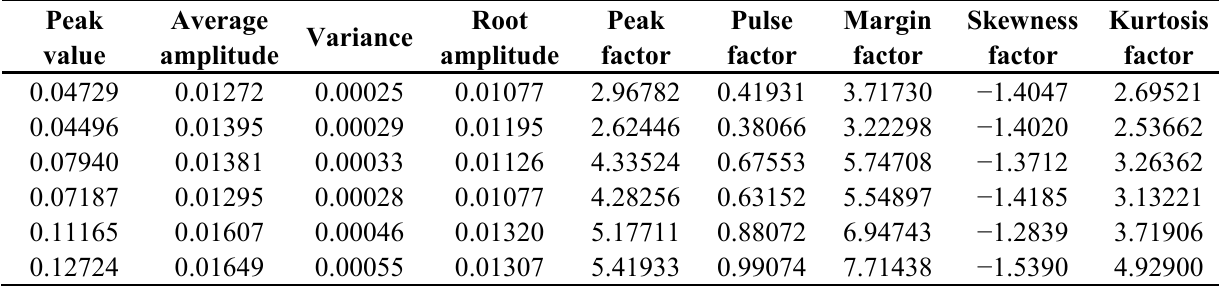
Table 1. Signal sample.